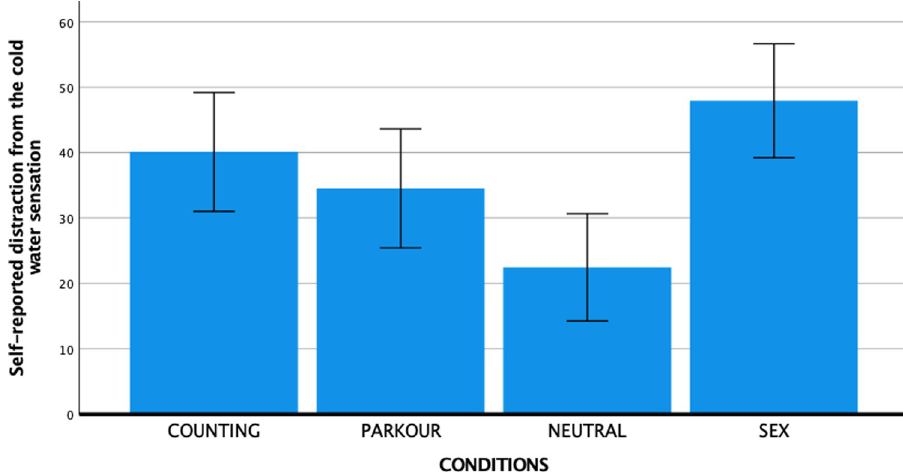
Fig 4. Mean self-reported distraction levels per condition with error bars representing 95% confidence